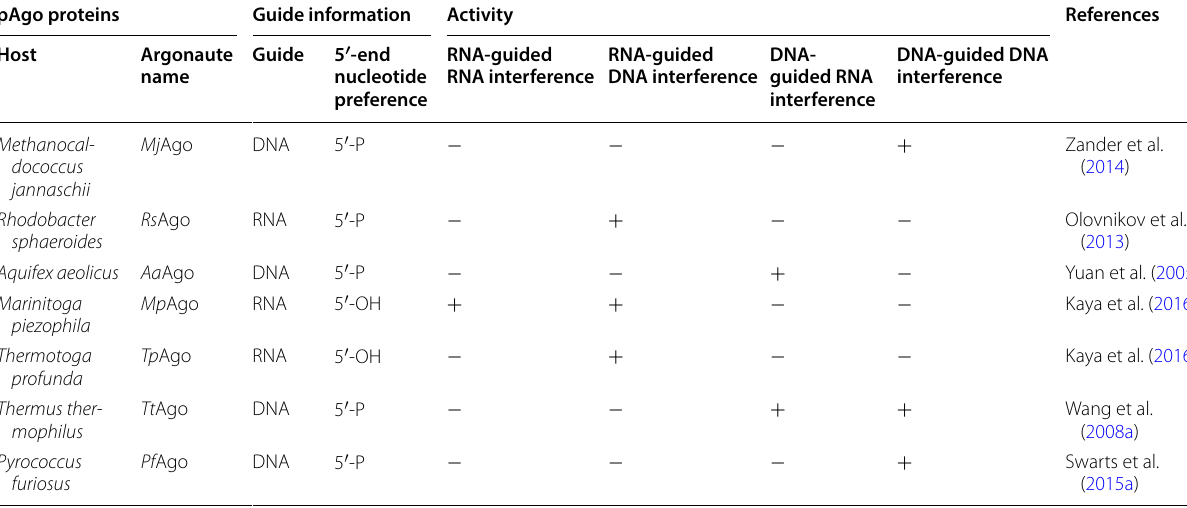
Table 1 Guide and target preferences of characterized pAgo proteins pAgo